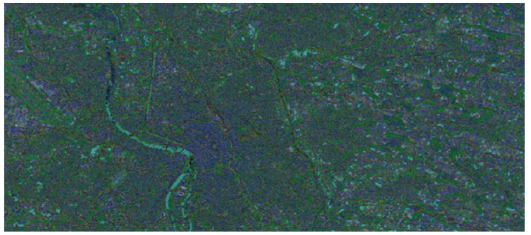
Fig. 10. City scale (Toulouse) land cover